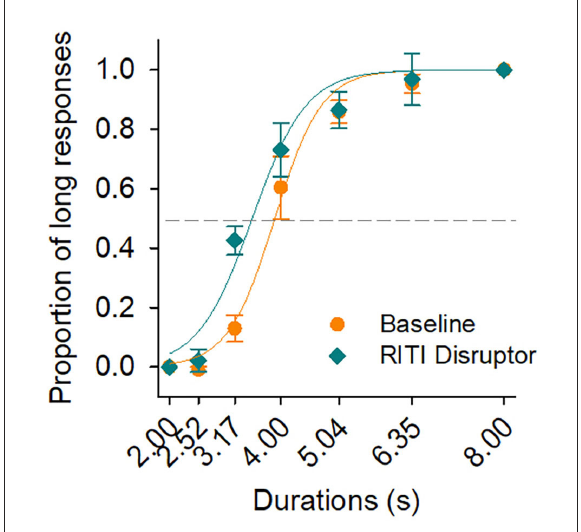
FIGURE1 Psychophysical functions at baseline and on disruption of reinforcement during the intertrial interval (RITI). Psychophysical functions at baseline (orange circles) and on RITI manipulation (green diamonds). The continuous line in orange color describes the best fitting of the sigmodal function for baseline, and the continuous line in green color describes the best fitting for RITI manipulation. Vertical bars represent SEM.